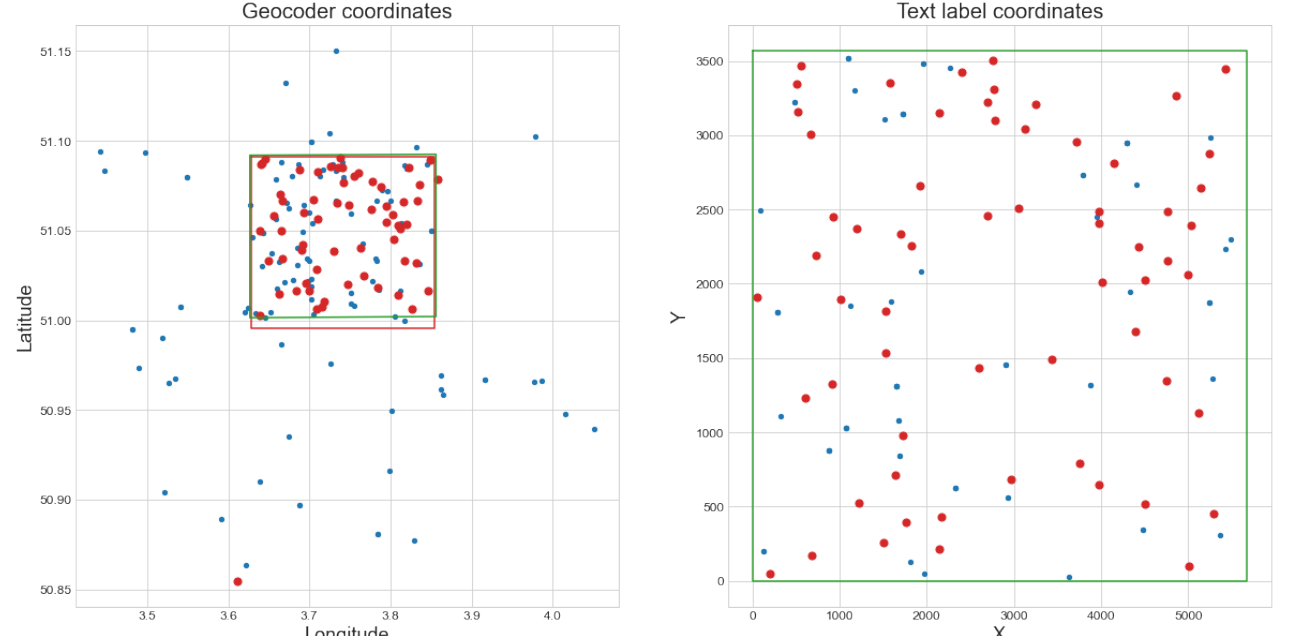
Figure 9. ( Left ) Latitude and longitude coordinates of the geocoder matches. The green and red rectangles denote the ground truth geolocation and the predicted geolocation, respectively. Point pairs selected during the RANSAC algorithm are shown in red, the others in blue. ( Right ) X and Y pixel coordinates of corresponding text labels. The green rectangle denotes the raster map bounds (width and height).